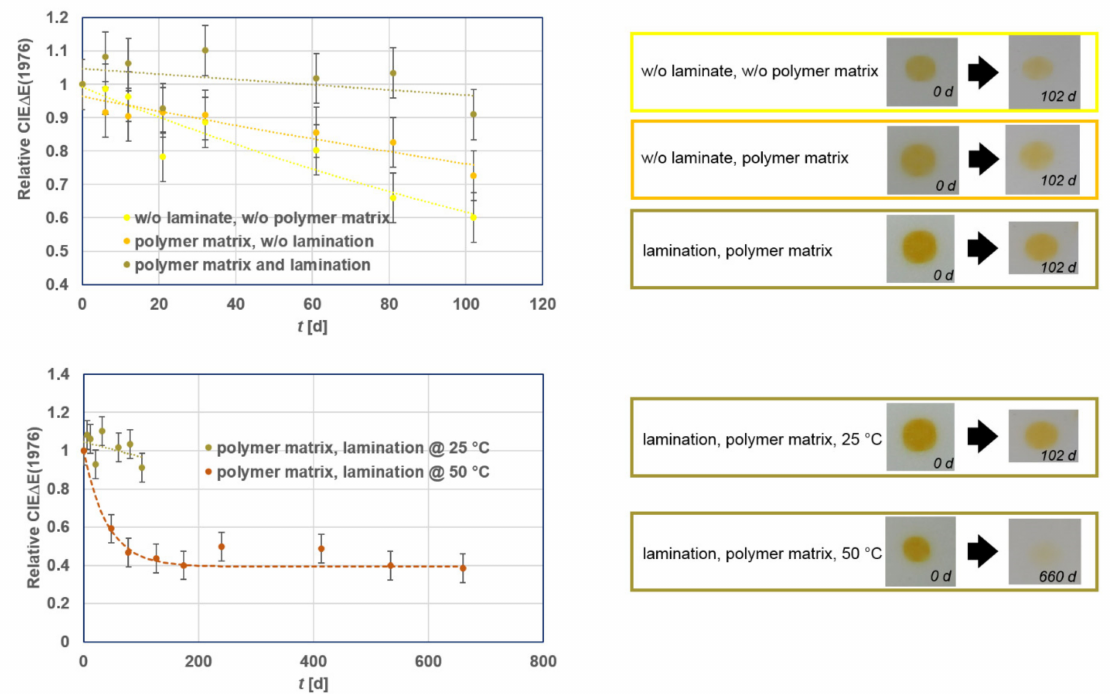
Figure 15. Top: Colorization performance of yellow VIS-trigger-able photochromic 12 µ m print layers with varying stabilization technology at 25 ◦ C within a period of 102 days of observation. Bottom: Colorization performance of the most durable yellow VIS-trigger-able photochromic stabilized colorant system at 25 and 50 ◦